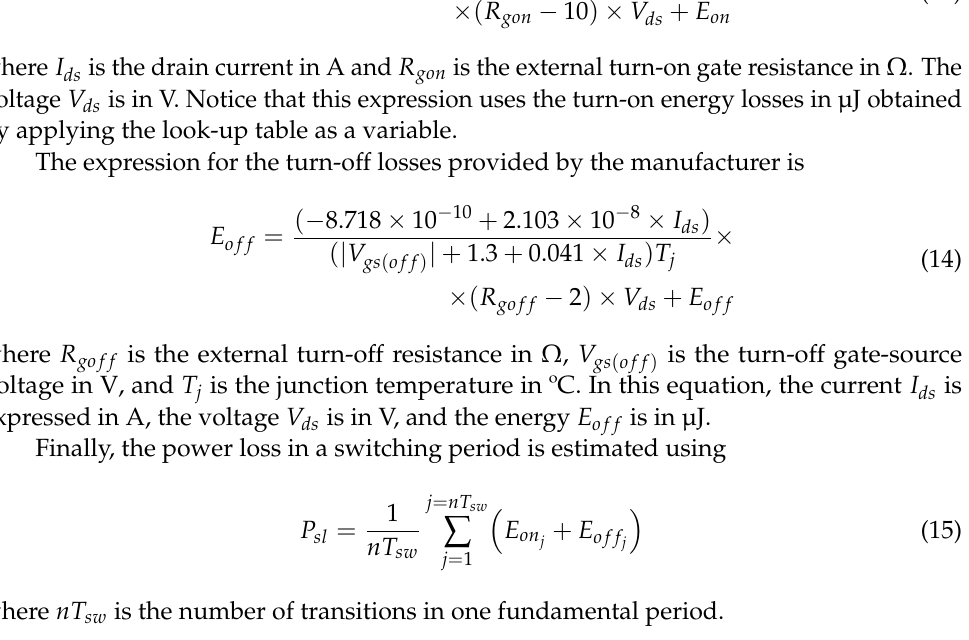
where I ds is the drain current in A and R gon is the external turn-on gate resistance in Ω . The voltage V ds is in V. Notice that this expression uses the turn-on energy losses in µJ obtained by applying the look-up table as a